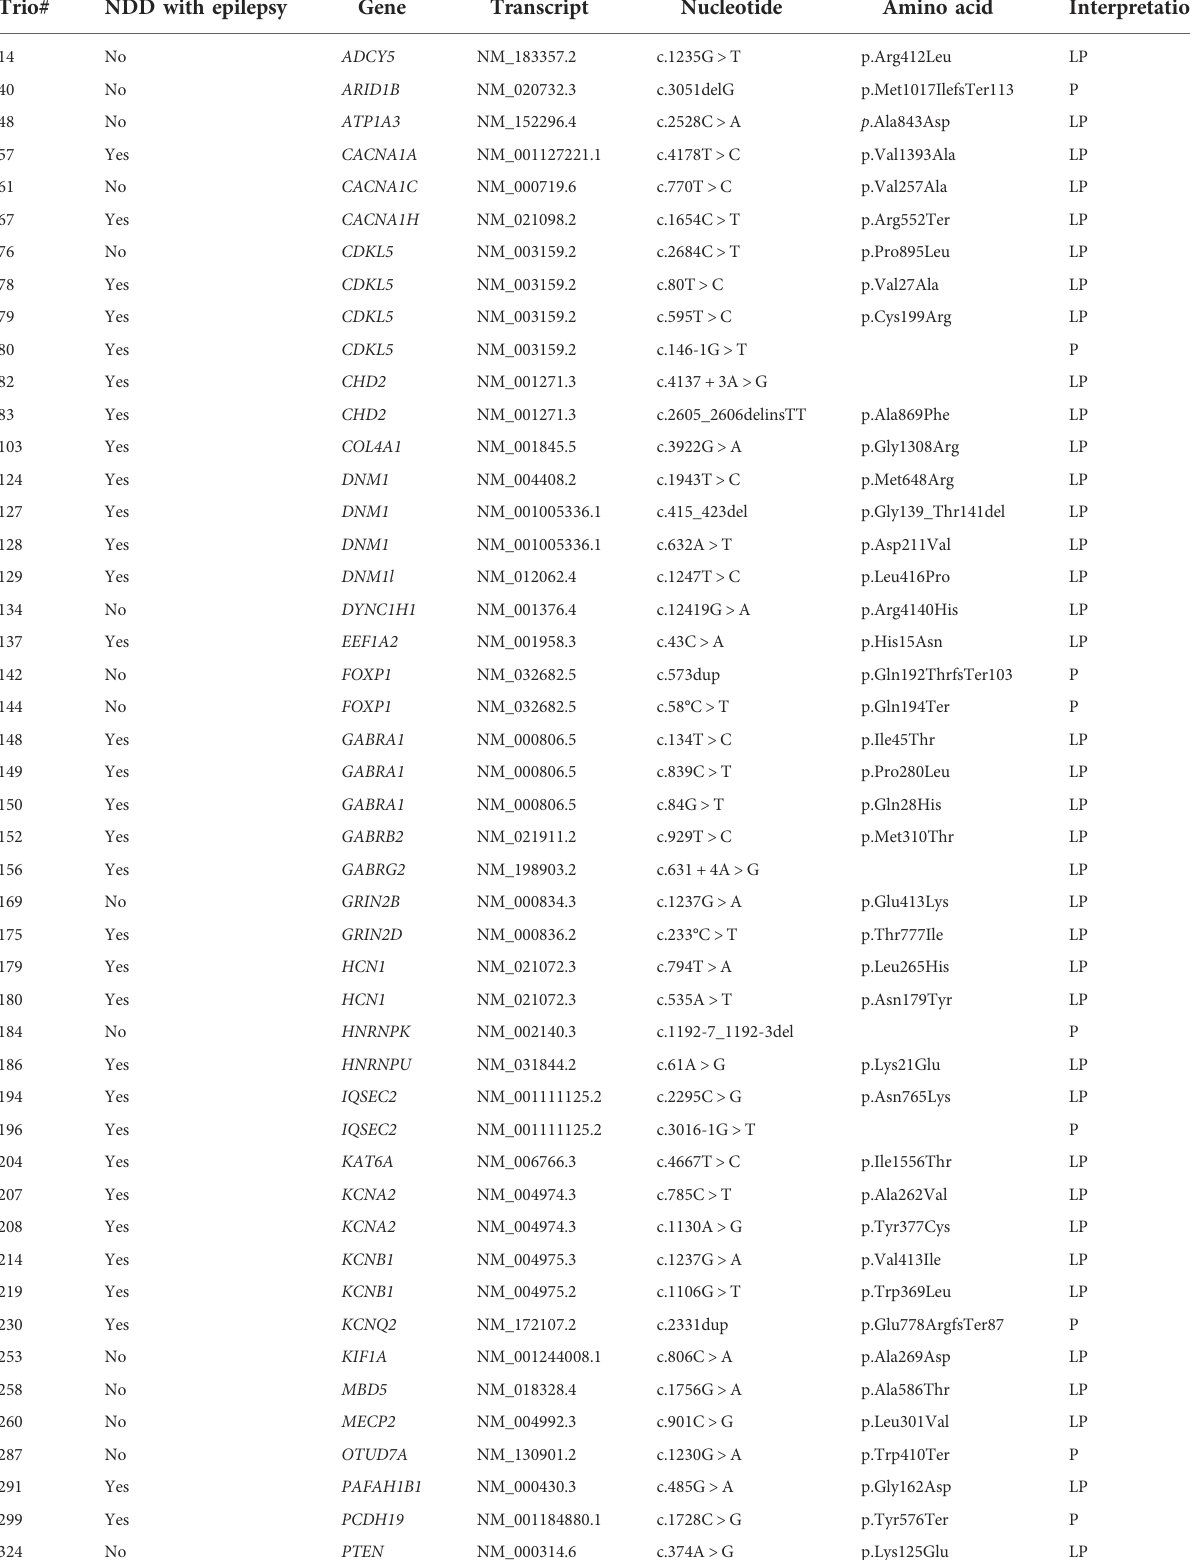
TABLE 2 Novel de novo pathogenic/likely pathogenic variants detected in patients with